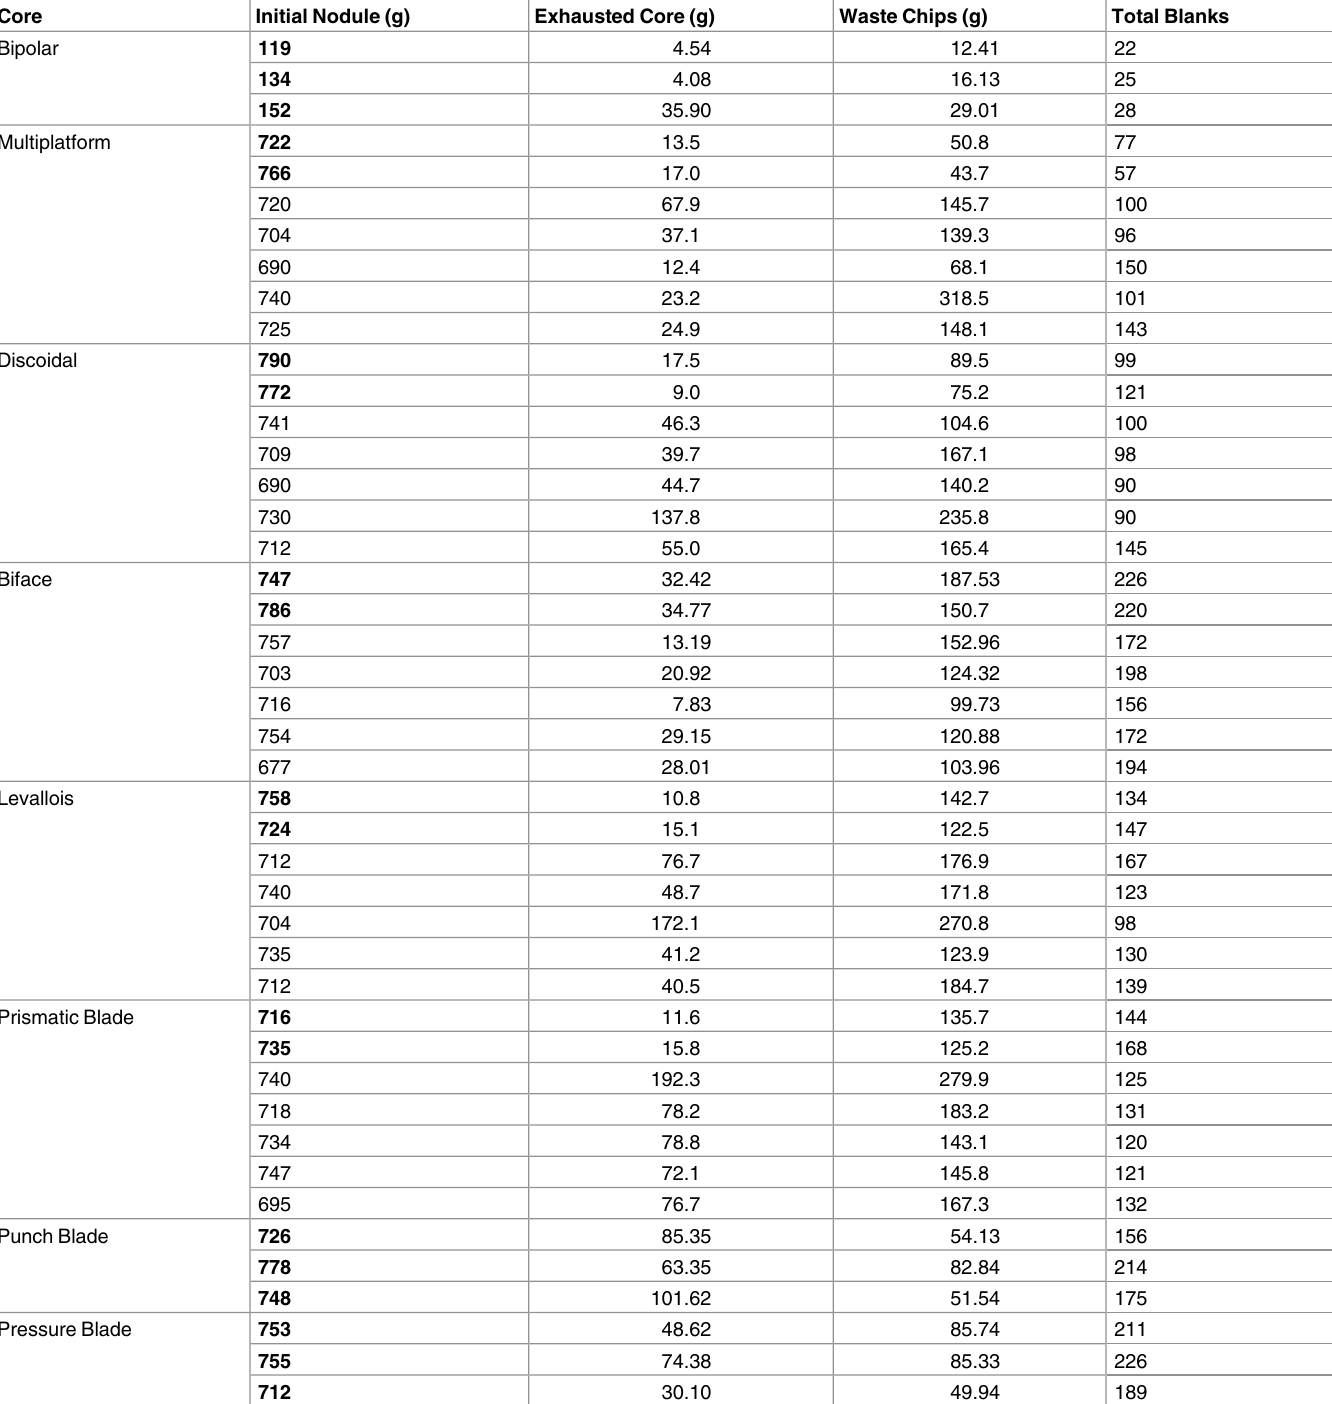
Table 1. Mass values of the bipolar, multiplatform, discoidal, biface, Levallois, prismatic blade, punch blade and pressure blade cores, waste and blanks from each reduction sequence. Initial nodulemasses in bold refer to reduction sequencesconductedby the expert